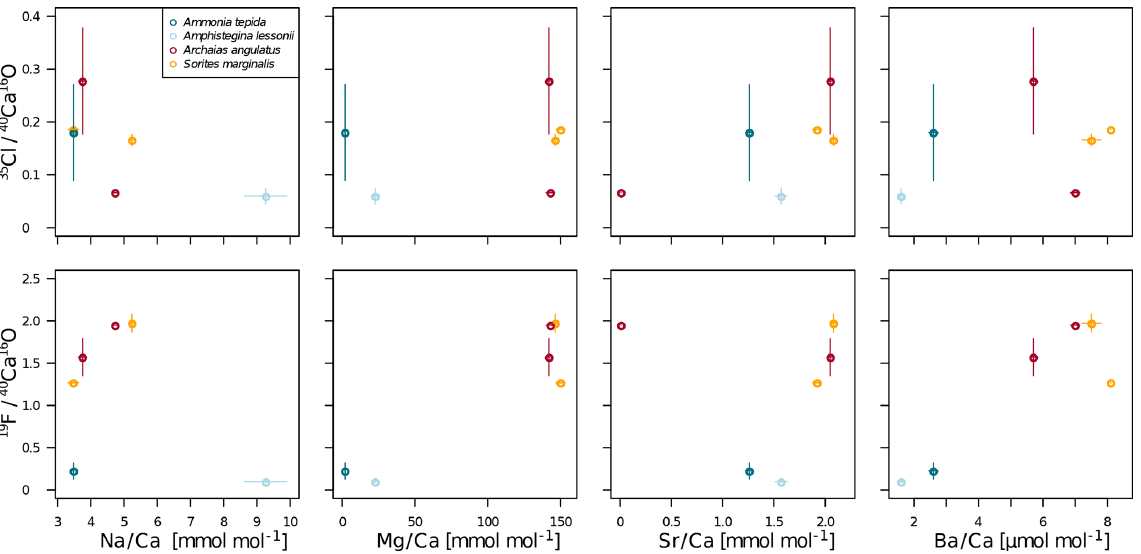
Figure 3. Cross plots of NanoSIMS 35 Cl / 40 Ca 16 O and 19 F / 40 Ca 16 O ion count ratios with LA-ICP-MS El / Ca ratios in the same specimen. The error bars depict 1 standard error of the mean NanoSIMS ion count ratios where more than one image was analysed per specimen and 1 standard error of duplicate or triplicate LA-ICP-MS measurements. The calculation of correlations was not attempted due to the low number of replicate measurements.